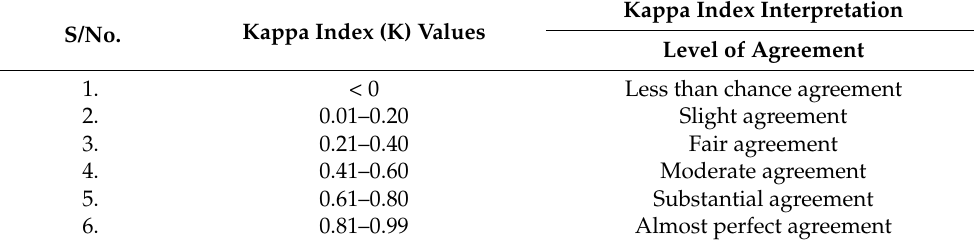
Table 3. Interpretation of kappa